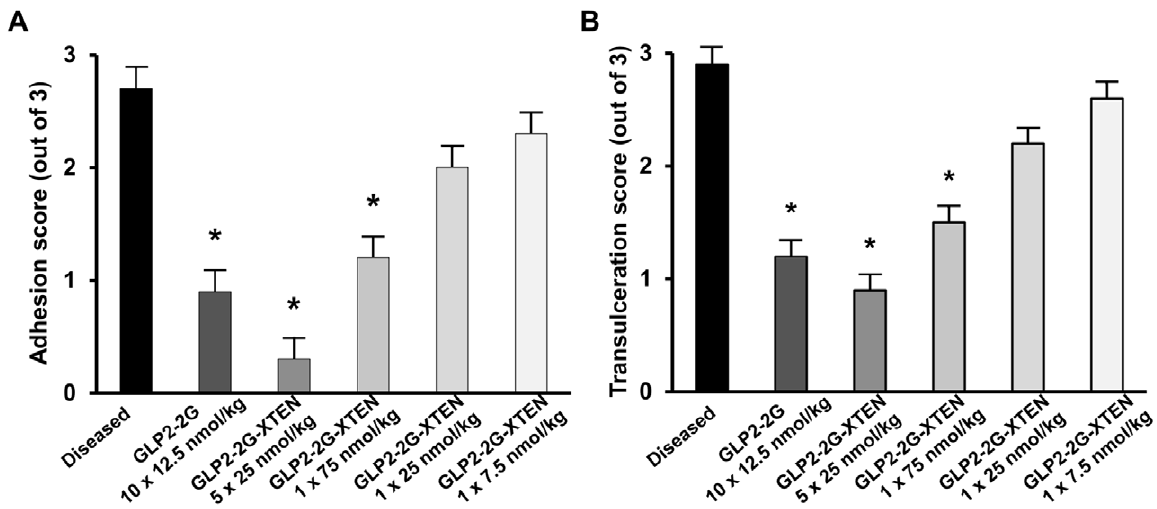
Figure 5. Efficacy of low dose GLP2-2G-XTEN treatment in rat indomethacin-induced disease model. Data shown are effects on A) small intestine adhesions and B) small intestine trans-ulcerations. Treatment with GLP2-2G peptide (12.5 nmol/kg per injection; twice per day for 5 days) or GLP2-2G-XTEN (25 nmol/kg once daily or only once at the indicated doses) was initiated on Day 2 3 and sacrifice is on Day 2. Data are means and SE, n=10 per group. * P , 0.05 compared to diseased, vehicle-treated rats.